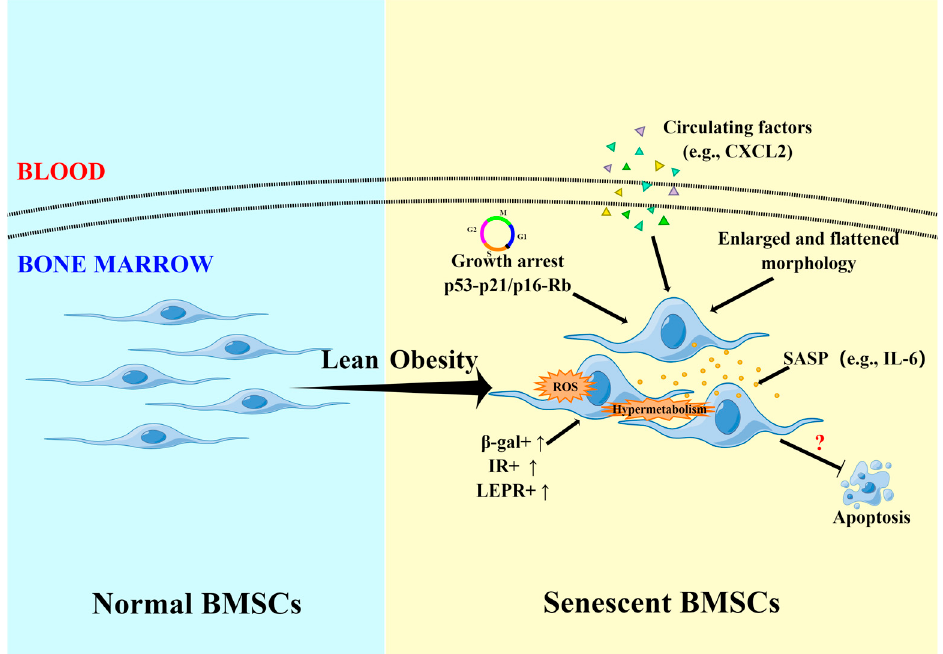
Figure 1. Obesity-associated senescent and apoptotic phenotype of BMSCs. Obese BMSCs are in- clined to senescence, displaying enlarged and flattened morphology, cell cycle arrest, SASP, in- creased senescence-related markers, etc. However, obesity seems to have no significant effect on apoptosis of BMSCs. T he exact underlying mechanism i s stil l unknown . BMSCs: bone mar- row-derived mesenchymal stem cells; CXCL2: C-X-C motif chemokine ligand 2; SASP: senescence-associated secretory phenotype; IL-6: interleukin 6; LEPR: leptin receptor; IR: insulin receptor; β -gal: senescence-associated β -galactosidase.